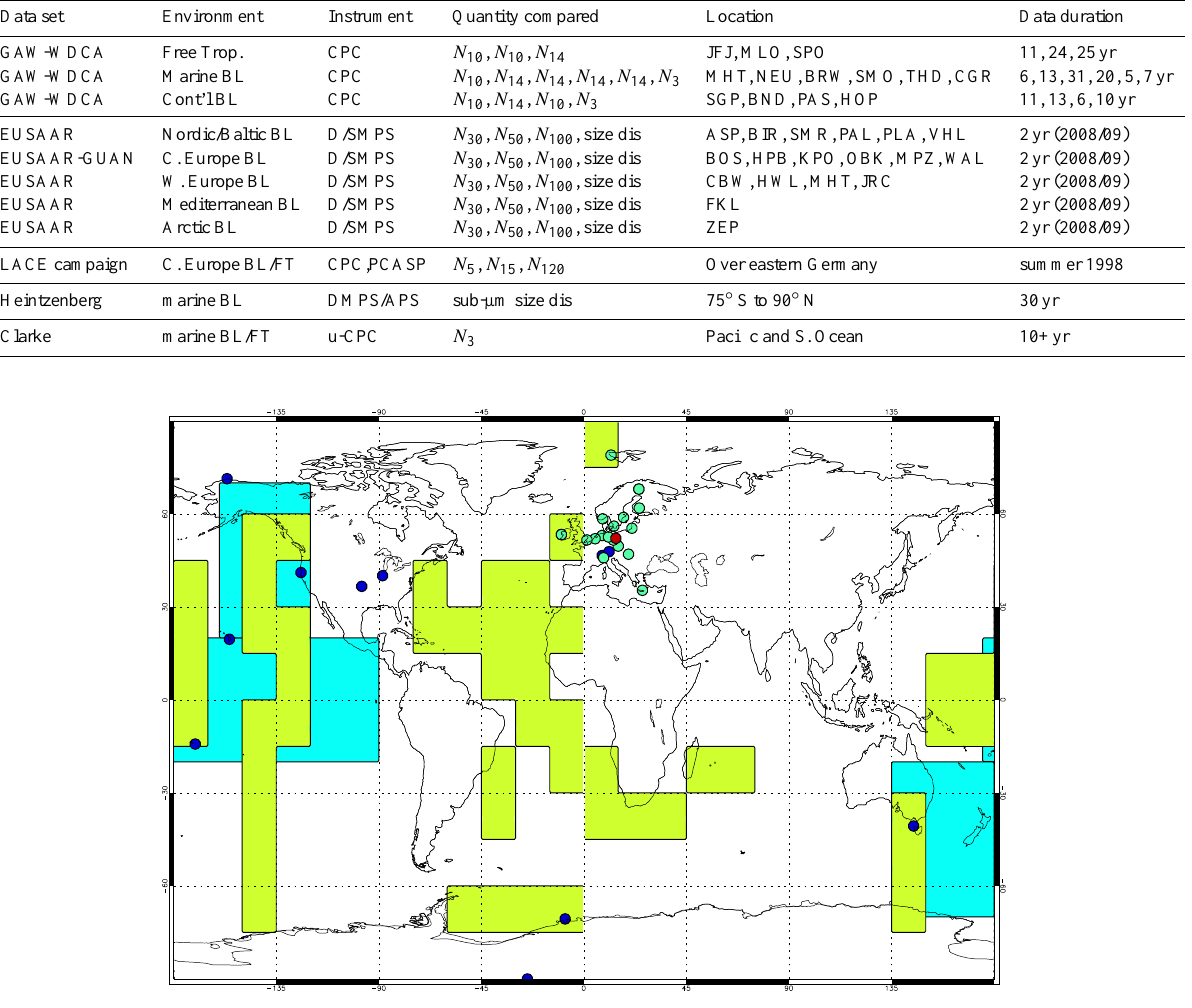
Figure 5. Global map indicating the locations of the measurement data sets shown in Table 3. Coloured circles show GAW-WDCA stations (blue), EUSAAR/GUAN supersites (aqua) and the location of the LACE 98 field campaign (red). The aqua boxed regions indicate where the aircraft field campaign measurements compiled in Clarke and Kapustin (2002) were made. The yellow boxed regions show the locations of the cruise campaign measurements compiled by Heintzenberg et al. (2000). When comparing to the measurements, each of the models was sampled based on a mask or interpolation to these